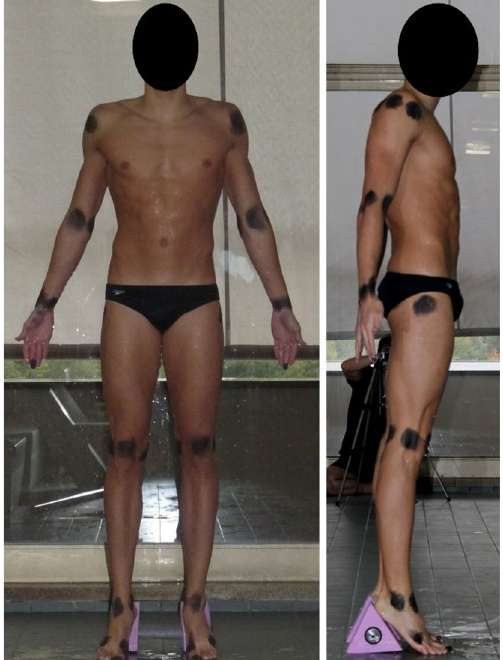
Figure 1. Frontal and side views of a participant marked with the oil and wax-based